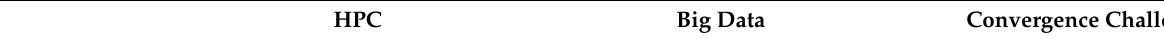
Table 1. Cont. HPC Big